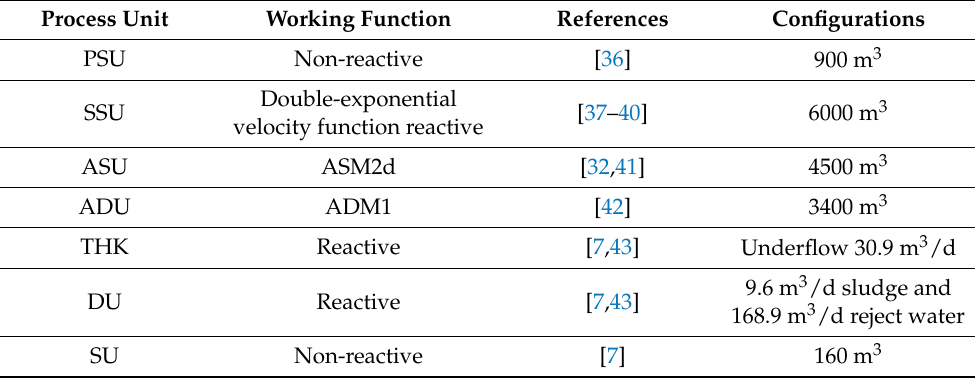
Table 2. Attributes of plant-wide model processes units and physical